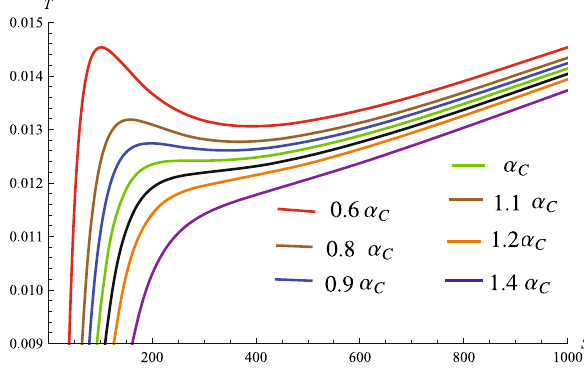
Fig. 2 The relationship between temperature T versus entropy S for varying α for the case l = 20 for neutral Gauss–Bonnet AdS black hole in four dimension